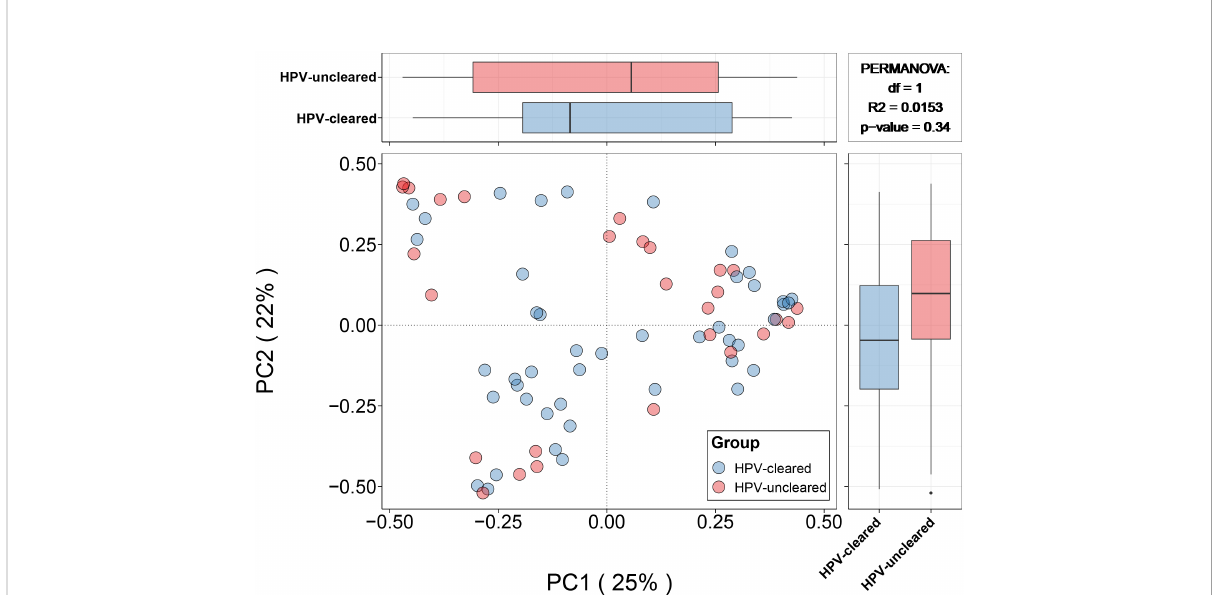
FIGURE 4 Principal coordinates analysis (for principal coordinates PCo1 and PCo2) plots with Bray – Curtis distance showing the difference in microbial community composition between the HPV-cleared and HPV-uncleared groups. Statistical signi fi cance between the groups was tested by permutational multivariable ANOVA. HPV, human